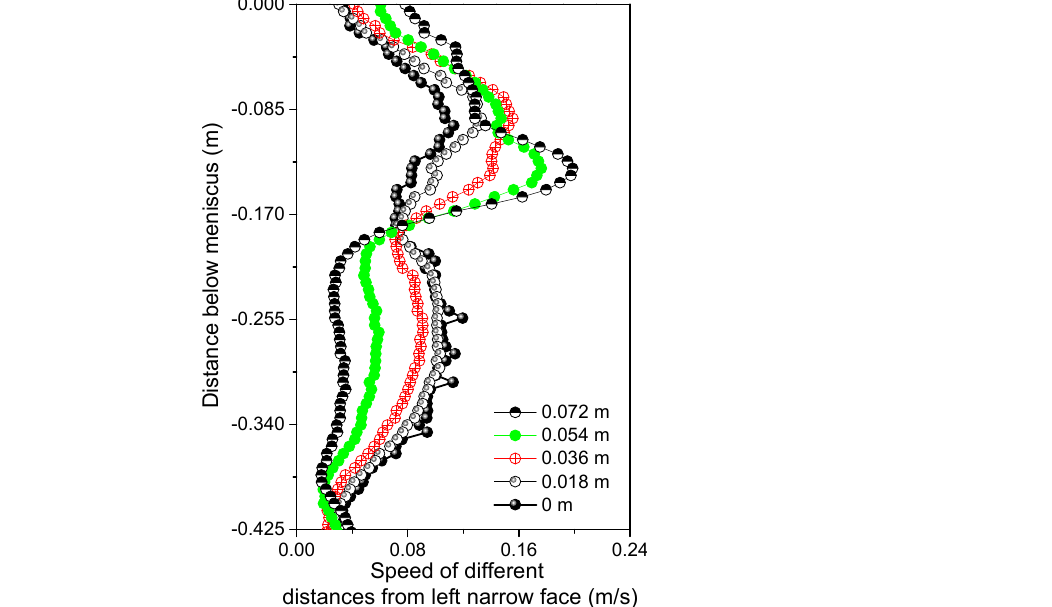
Figure 21. Schematic diagram of the output position of the velocity and velocity at different dis- tances from the narrow surface.